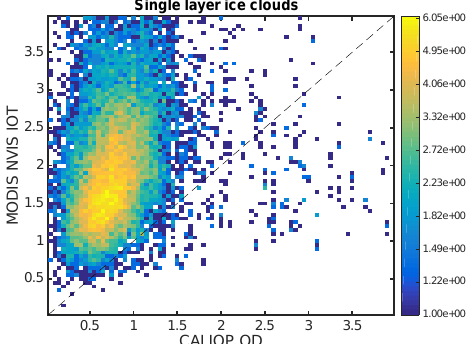
Figure 1. A two-dimensional histogram comparing MODIS C5 and CALIOP V3 single-layer ice cloud daytime optical thickness re- trievals for January 2010 (ocean surfaces, ± 60 ◦ latitude). Note that the color scale is